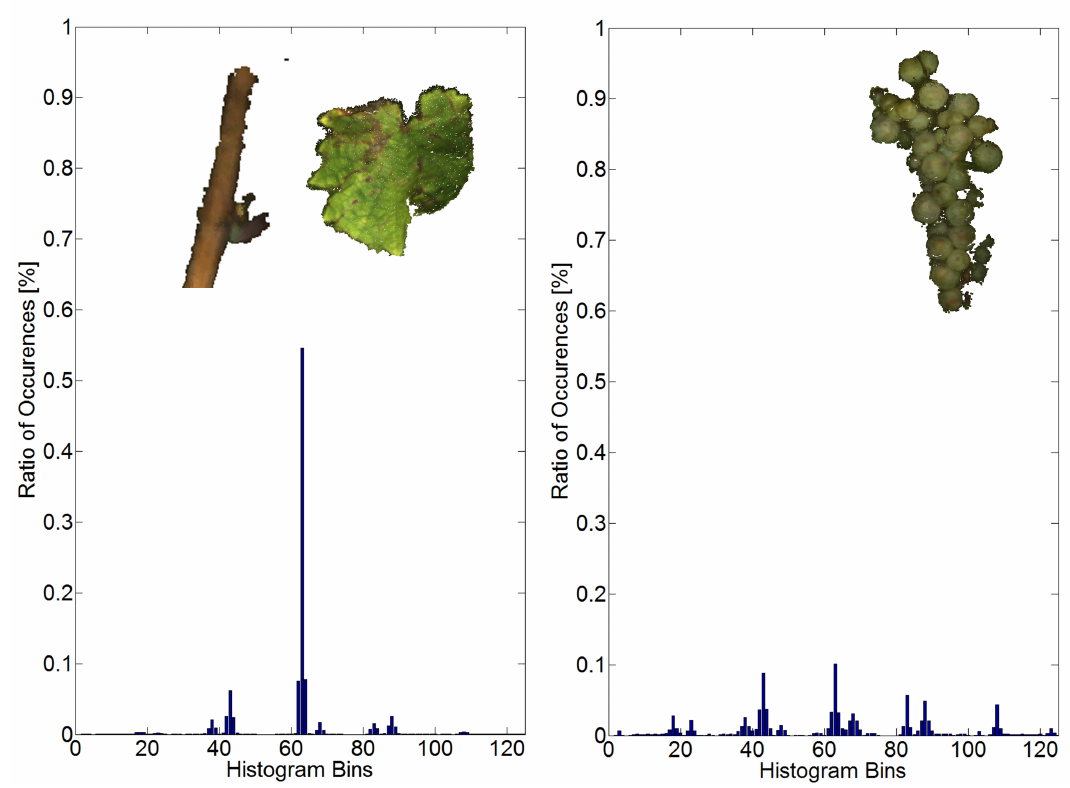
Figure 7. ( Left ) Typical surface feature histogram (SFH) for the canopy; ( Right ) Typical SFH for grape